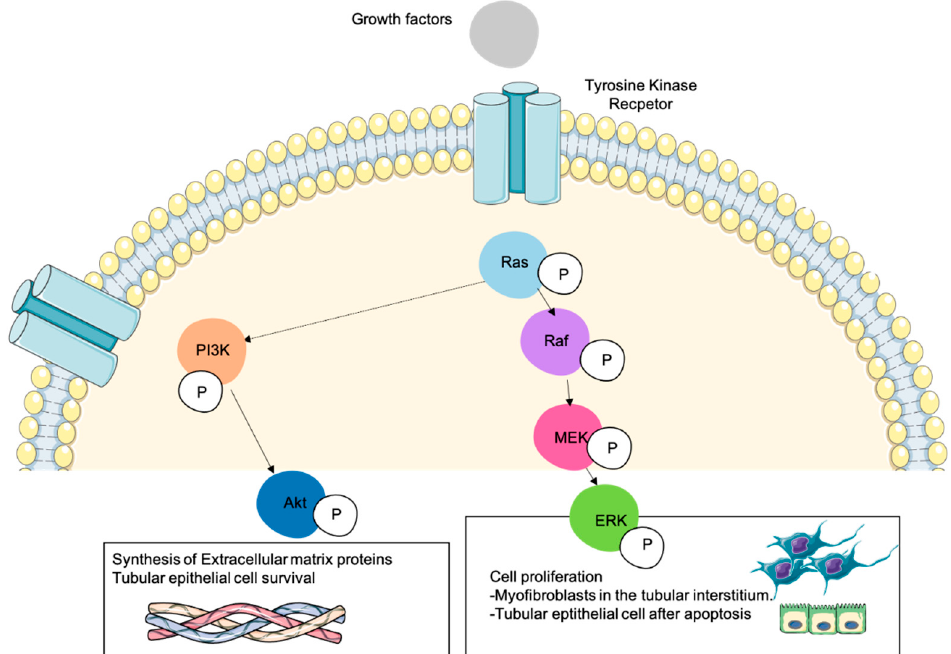
Figure 2. Role of Ras downstream signaling pathways in cellular processes involved in kidney fibrosis. Numerous cellular mechanisms take place during kidney fibrosis by the action of several pro-fibrotic cytokines or growth factors that activate different receptors such as tyrosine kinase. Resident fibroblasts are activated and transdifferentiated into myofibroblasts that proliferate and synthesize ECM proteins. The deposition of ECM proteins and the action of profibrotic cytokines induce renal parenchymal cell death. The activation of Ras can activate the MAPK-ERK1/2 pathway (phosphorylating Raf and MEK), being this the major mechanism that promotes cell proliferation. Resident fibroblasts are transdifferentiated into proliferating myofibroblasts that produce high amounts of ECM proteins. At the same time, several profibrotic cytokines such as TGF- β 1 induce tubular cells apoptosis, and some tubular epithelial cells proliferate to counteract this cell death process. All these mechanisms are induced by the ERK1/2 pathway. The regulation (negative or positive depending on the context) of PI3K-Akt by Ras can affect other cellular processes such as ECM proteins synthesis or the promotion of tubular epithelial cells survival. In this figure we represent a Ras-expressing cell during kidney fibrosis in which Ras has been activated by growth factors and its signal has been transduced to their downstream effectors ERK and Akt.